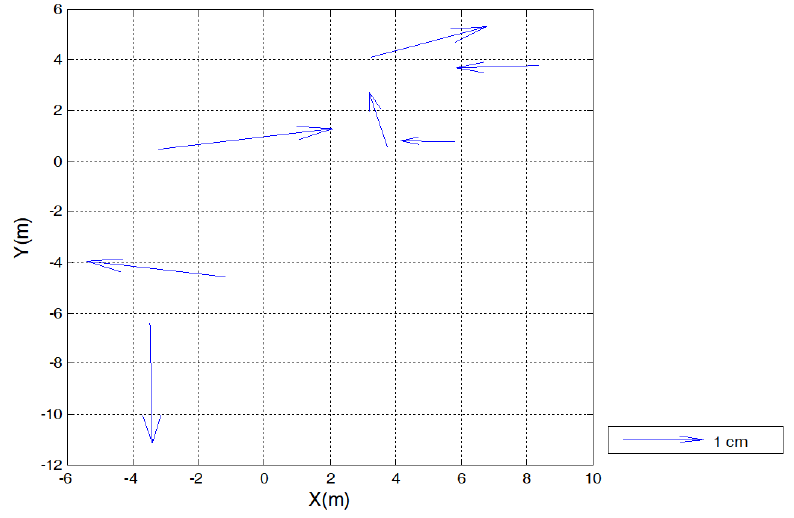
Figure 7. Needle map of the residuals resulting from the rigid-body transformation using the least-squares method.